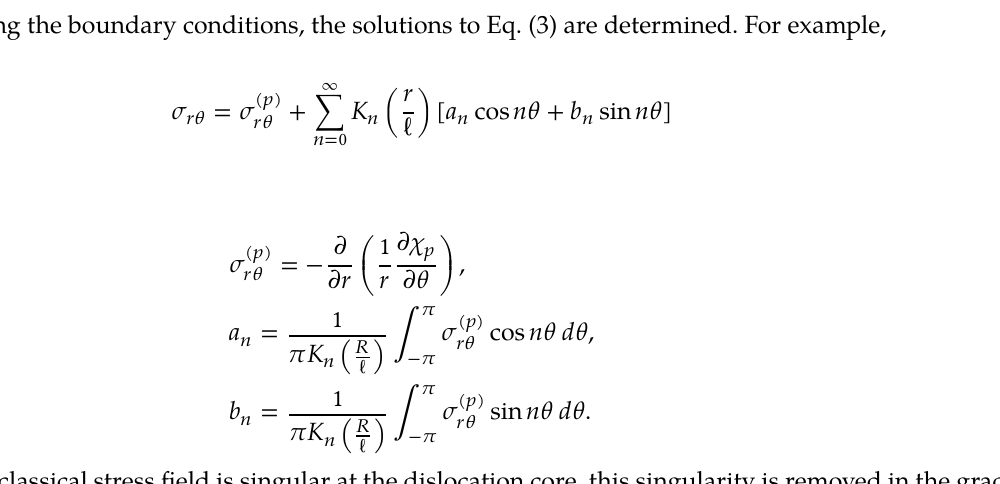
= 0, R = 20 ℓ and β = y